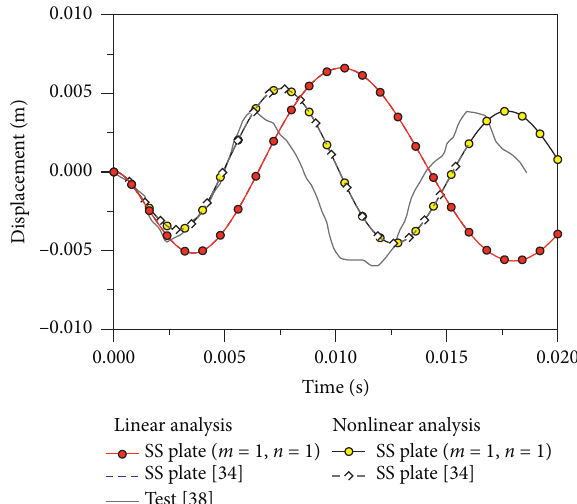
Figure 9: Out-of-plane displacement for a square steel plate under field blast loads, as obtained from the presently developed SDOF model and from literature [33, 38]. In evidence, the results are given by the linear and nonlinear solutions for the SS boundary